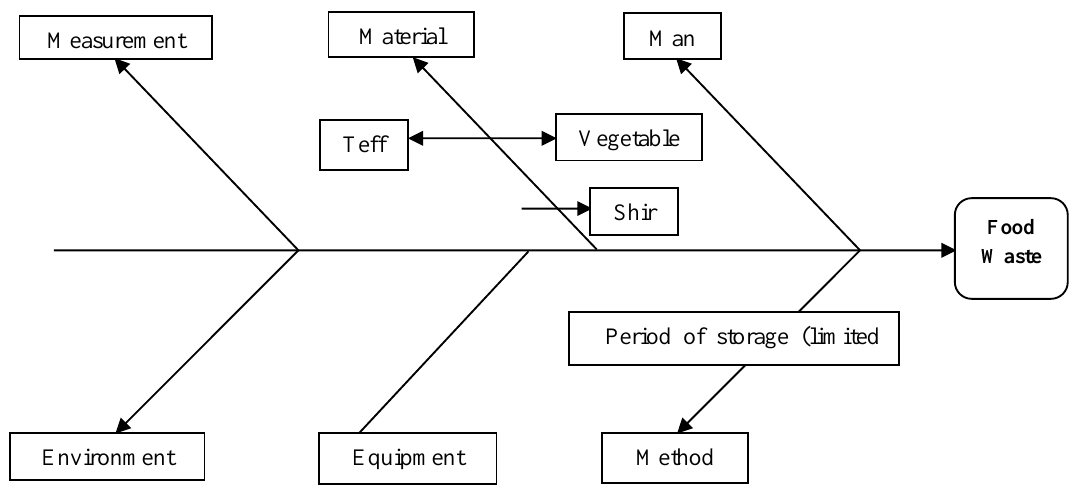
Figure 3. Couse and effect